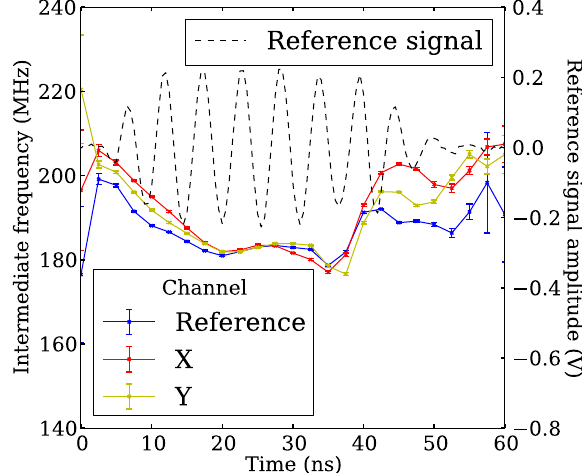
FIG. 9. Maximum reference signal amplitude for different beam pulse lengths.